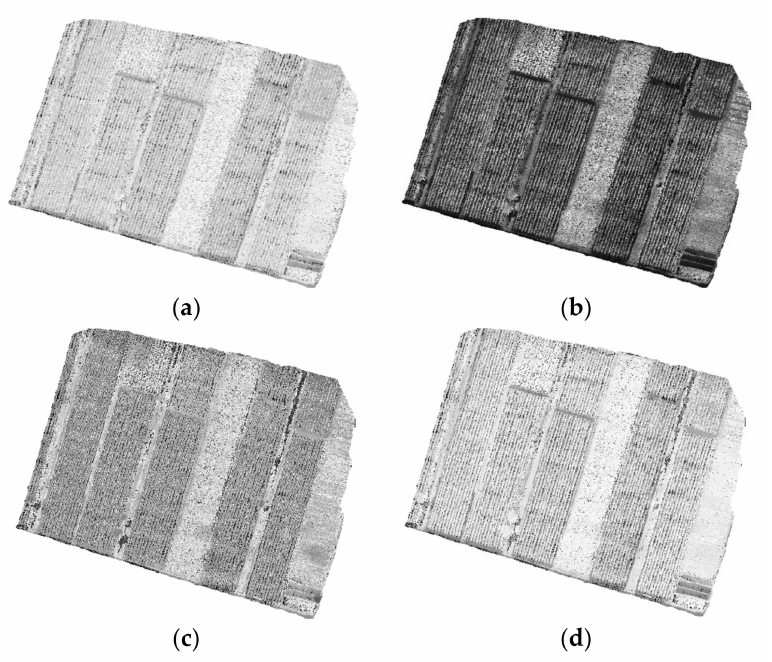
Figure 7. Map of each vegetation index in the study area. ( a ) Normalized Difference Vegetation Index (NDVI). ( b ) Ratio Vegetation Index (RVI). ( c ) Difference Vegetation Index (DVI). ( d ) Soil Adjustment Vegetation Index (SAVI).